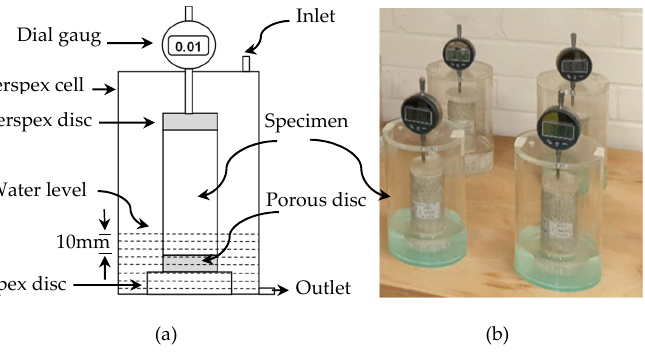
Figure 4. Linear expansion test; (a) schematic diagram of a perspex cell test set-up, (b) specimens during the linear expansion test.